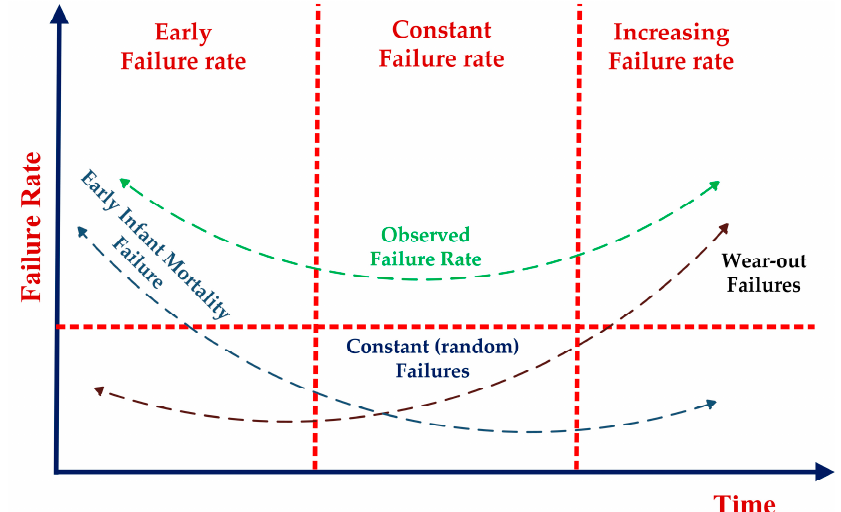
Figure 17. Classical bathtub curve.